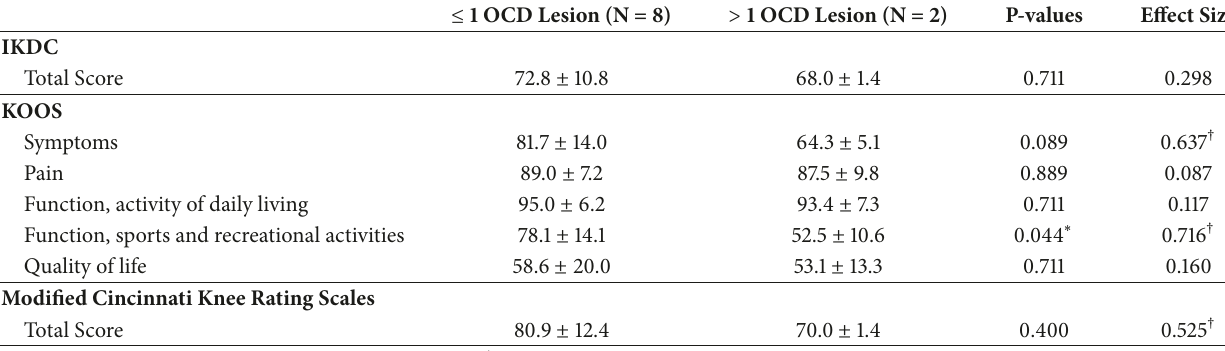
Table 7: Comparison of the patients’ reported outcome scores by number of OCD lesions before